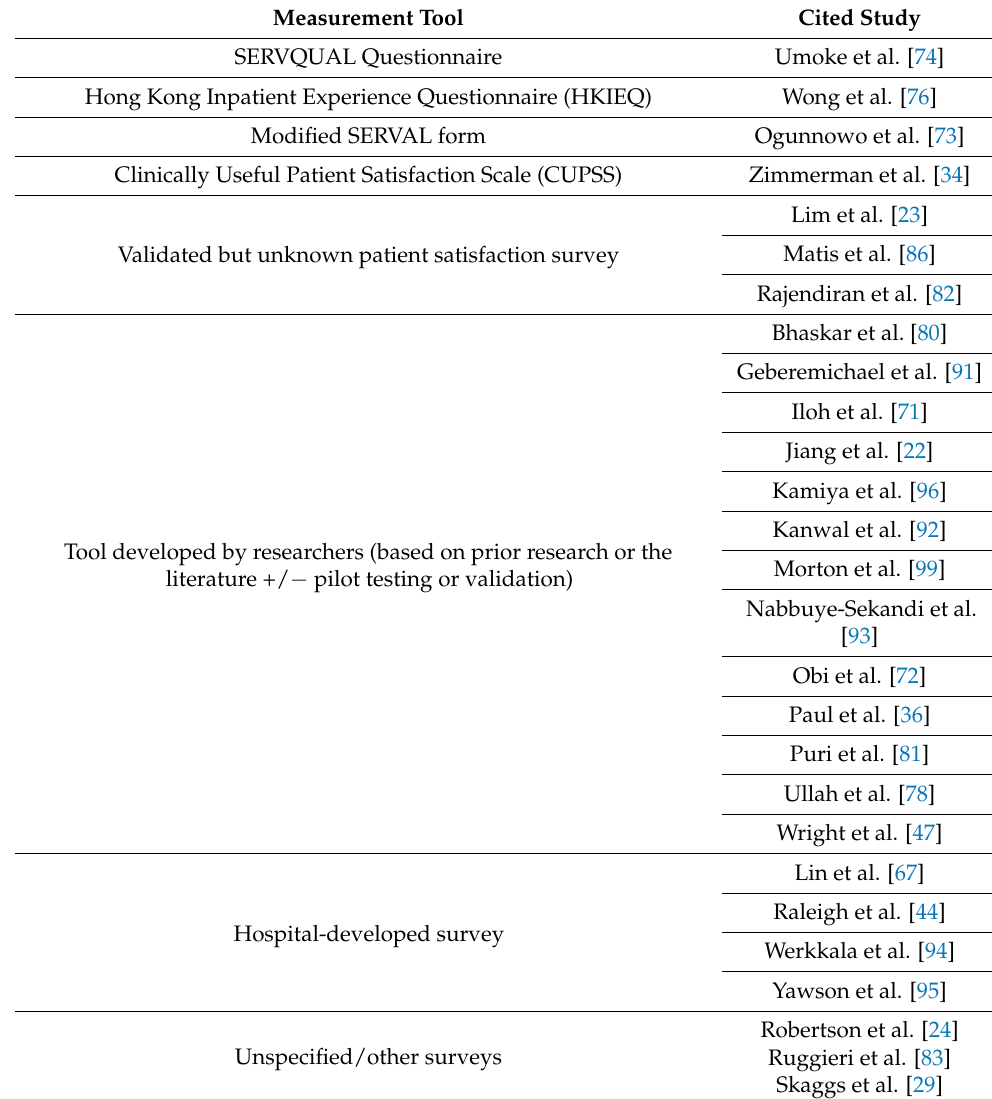
Table 3. Tools cited within the included primary studies for measuring individual patient-reported outcomes within acute settings.